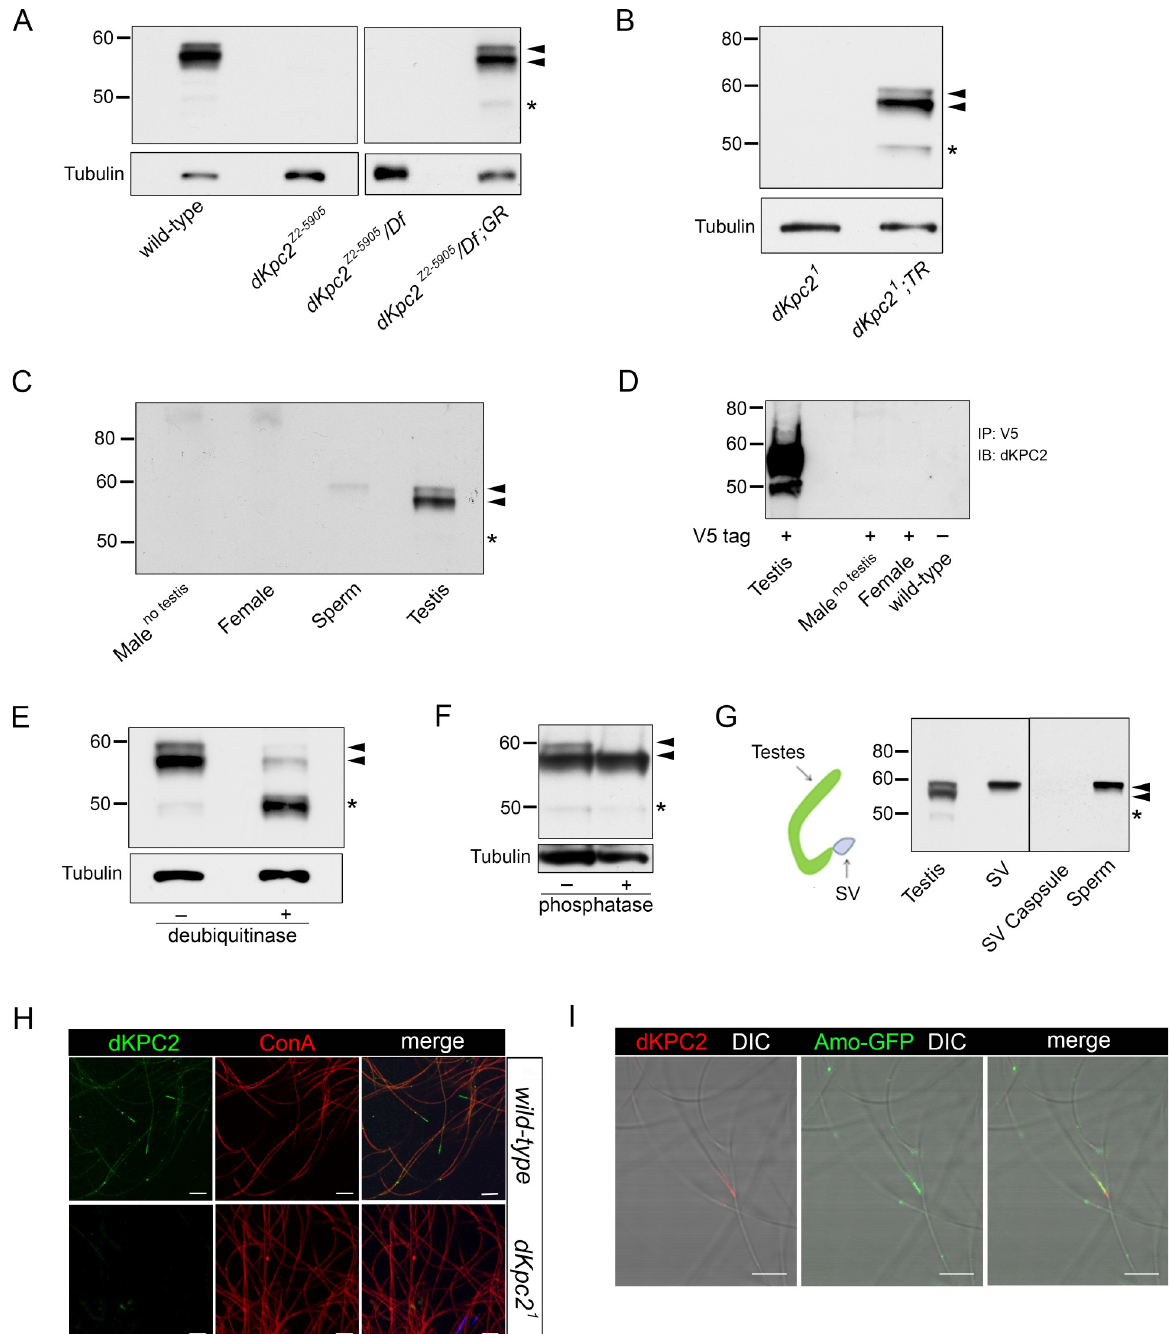
Fig 3. Drosophila KPC2 is a mono-ubiquitinated protein that co-localizes with Amo at the tip of the sperm tail. (A-G) Western blots probed with antisera to dKPC2. (A, B) Anti-dKPC2 recognizes three isoforms in wild type male testes indicated by arrowheads and an asterisk. These bands are absent in Z2-5905 (A) and dKpc2 1 (B) mutant testes. All three dPKC2 isoforms are visualized upon re-expression of dKPC2 using a genomic rescue construct (GR) or by testis-specific re-expression of dKpc2 Transcript B ( dKpc2 1 ; TR ). Loading control: Tubulin. (C) dKPC2 is expressed in testis and sperm but cannot be detected in females or in males lacking testes. (D) Anti-V5 was used to immunoprecipitate (IP) lysates prepared from transgenic flies with a V5 tagged- dKpc2 genomic construct. dKPC2 is expressed in testis but is absent in females and males lacking testes. (E-F) Lysates were prepared from wild type testes and treated with either deubiquitinase (E) or phosphatase (F). In (E), deubiquitinase shifts the ~58 kDa doublet down to ~49 kDa, suggesting that it is monoubiquitinated. In (F), phosphatase shifts the upper band in the ~58kDa doublet down suggesting that dKPC2 is monoubiquitinated and phosphorylated. Black arrow heads indicate the dKPC2 doublet at ~58kDa. The asterisk denotes the unmodified product of Transcript B at ~49kDa. (G) Schematic of the male reproductive tract showing structures that